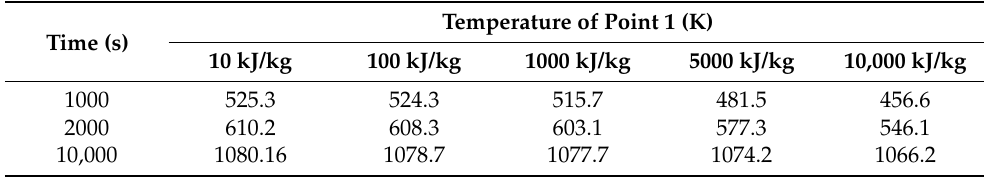
Table 13. Temperature-rise rate with different reaction heats at different times. Temperature-Rise Rate of Point 1 Time Interval (s)